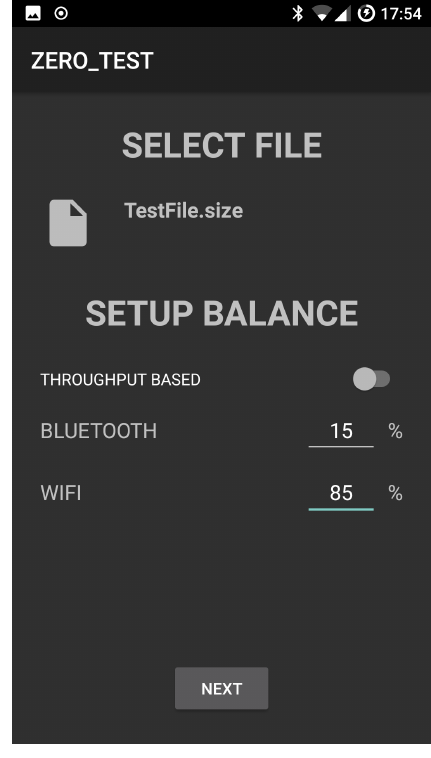
Figure 9. File upload and balance setup.